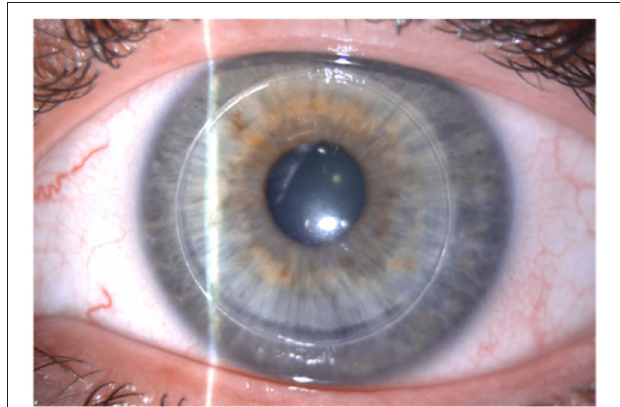
TABLE 1 | Pre-operative data of the